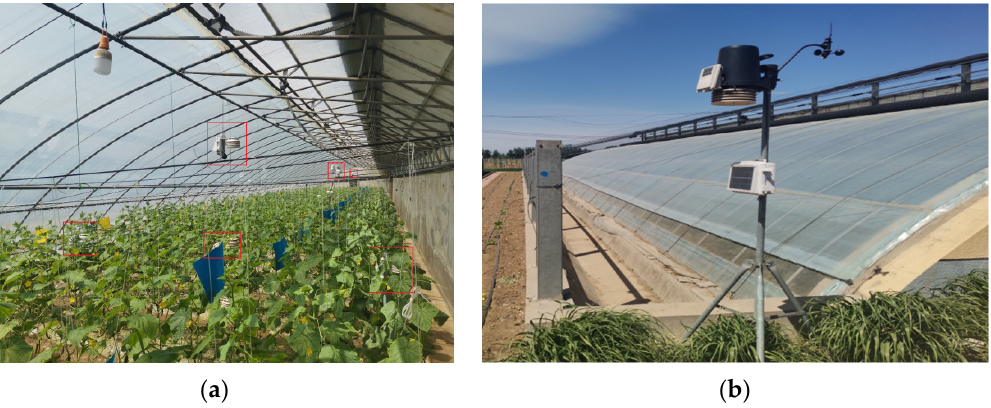
Figure 2. Photos of equipment installation. ( a ) Photo of the indoor sensors. ( b ) Photo of the weather station.